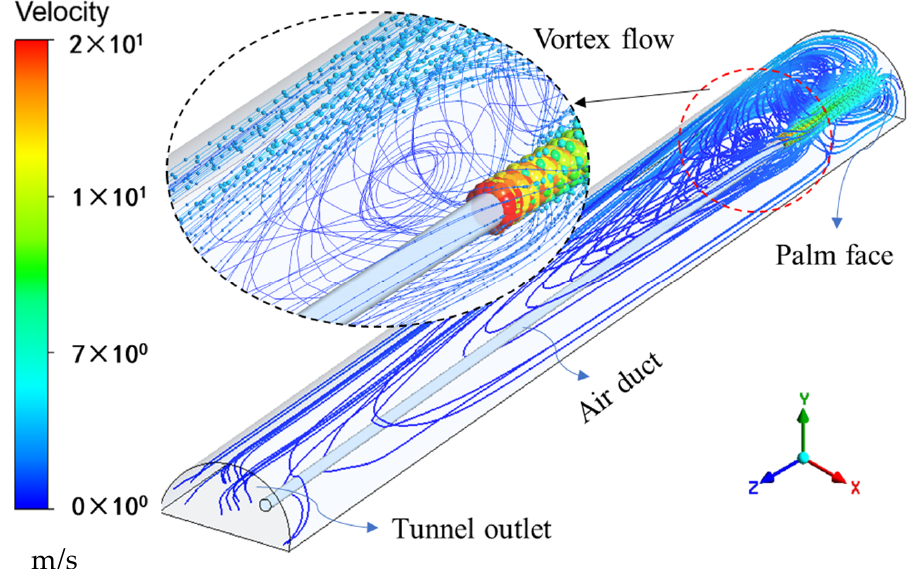
m/s Figure 2. Distribution of airflow streamlines in the tunnel. Figure 2. Distribution of airflow streamlines in the